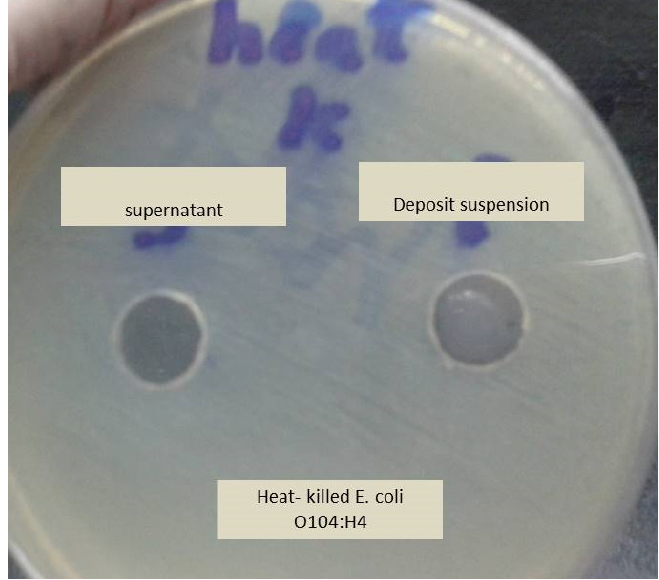
Figure 2. The effect of heat ‐ killed bacteria (autoclaved) on the growth of fresh viable E. coli O104:H4. No antimicrobial activity was shown on the bacterial growth.